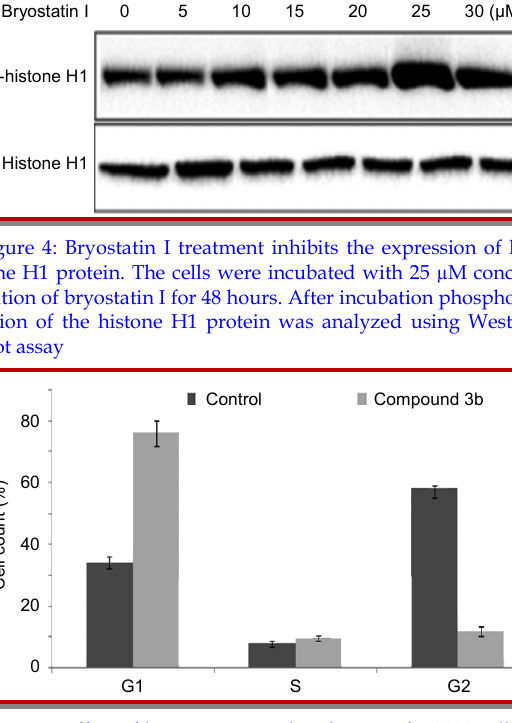
Figure 5: Effect of bryostatin I on distribution of H3922 cells in cell cycle. The cells were treated with bryostatin I and then analyzed by flow cytometry. Bryostatin I treatment increased the population of cells in G1 phase with subsequent reduction in G2/M